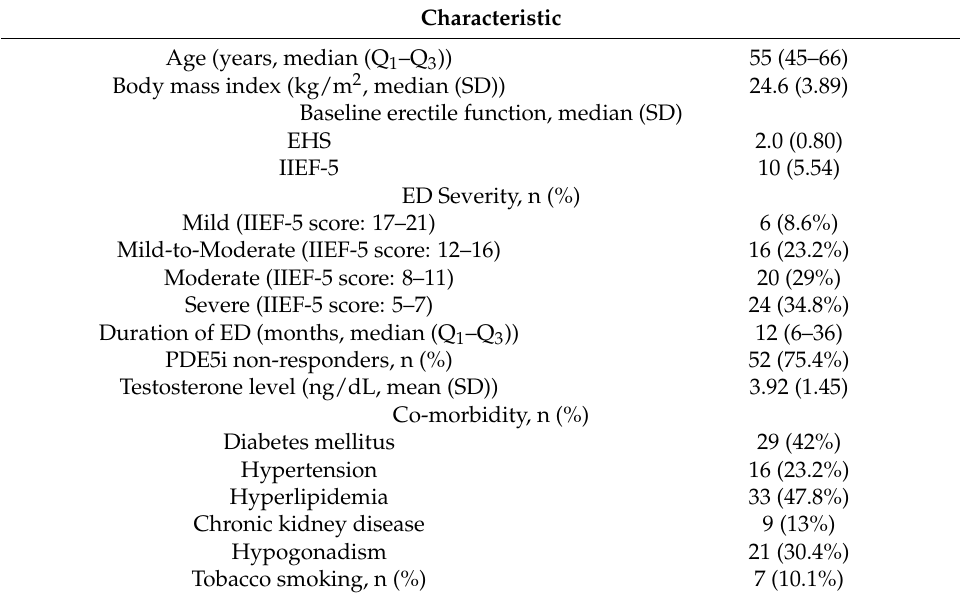
Table 1. Baseline characteristics of the study population (n = 69).